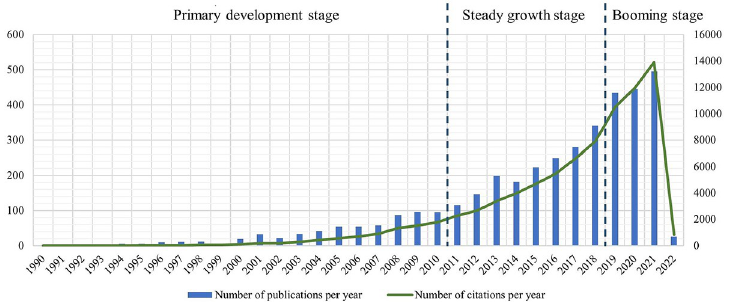
Fig 2. Annual distribution of publications and citations, 1990–2022.